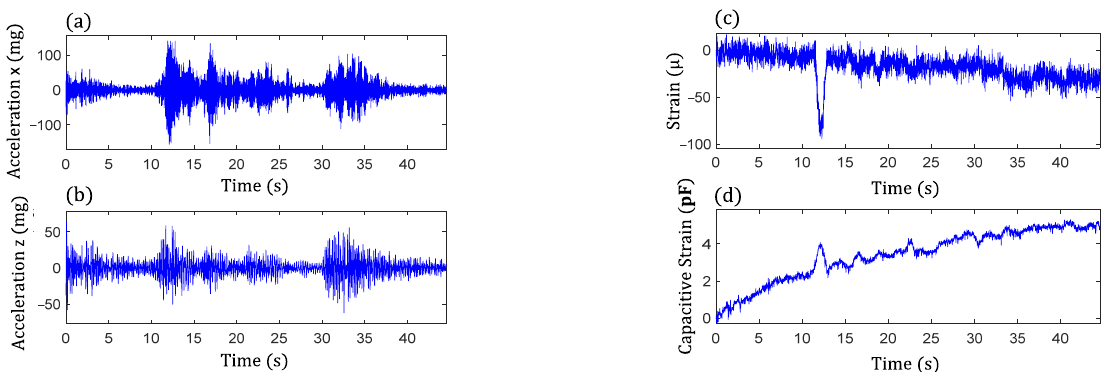
Figure 13. A sample data set from the WLASS including: ( a ) lateral acceleration and ( b ) vertical acceleration; ( c ) cross-frame strain, F ( t ) ; and ( d ) large-area strain, ∆ C ( t ) .